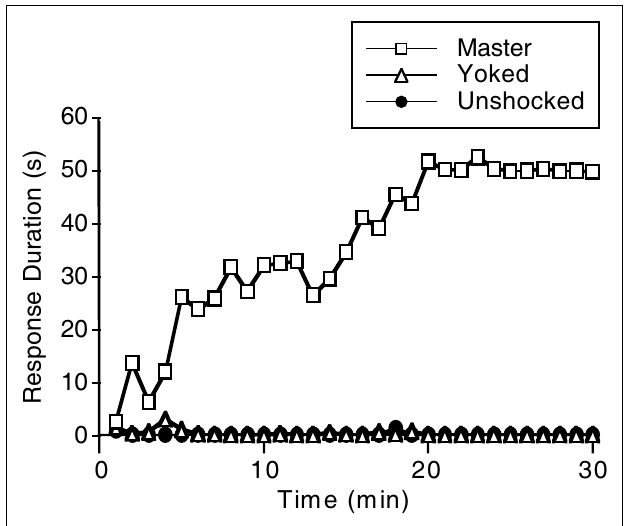
FIGURE 2 | Impact of training on response duration. Spinally transected rats received controllable shock (Master), uncontrollable shock (Yoked), or nothing (Unshocked). Master rats exhibited a progressive increase in response (flexion) duration across the 30min of training.Yoked rats, that received an equal amount of shock independent of limb position, did not exhibit an increase in response duration. Adapted from Grau et al. (1998).